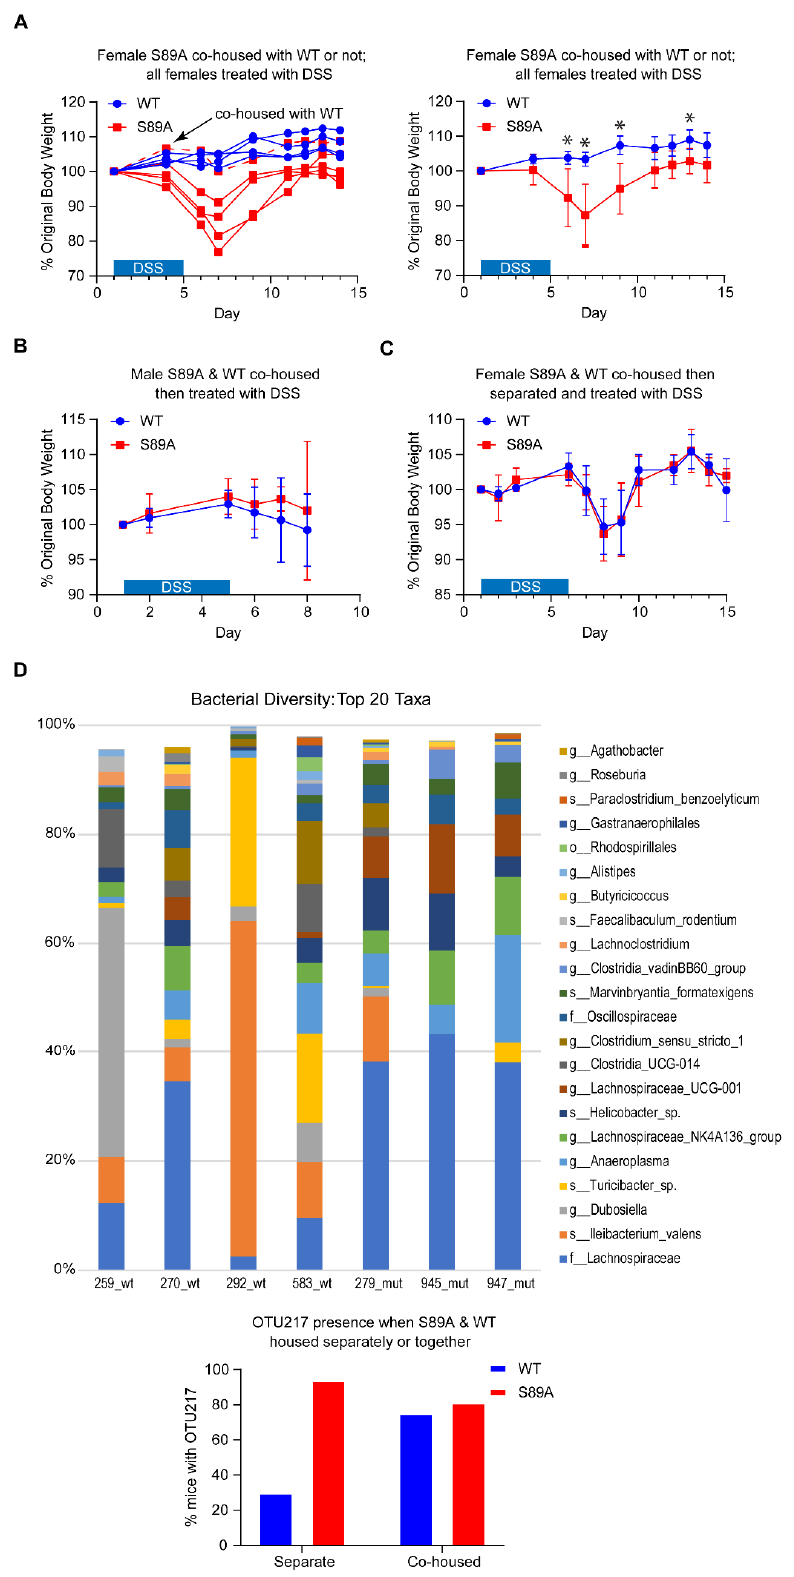
Figure 4. Co-housing of p300 S89A mice with wild type mice modulates severity of intestinal injury potentially via intermixing of microbiota. S89A and WT mice were treated on day 1 for ~4–5 days with low (2%) dose of dextran sodium sulfate (DSS) after which treatment was discontinued for ~7 days ( A , C ) or ~2 days ( B ), and the effect of DSS on % original body weight was assessed. A single